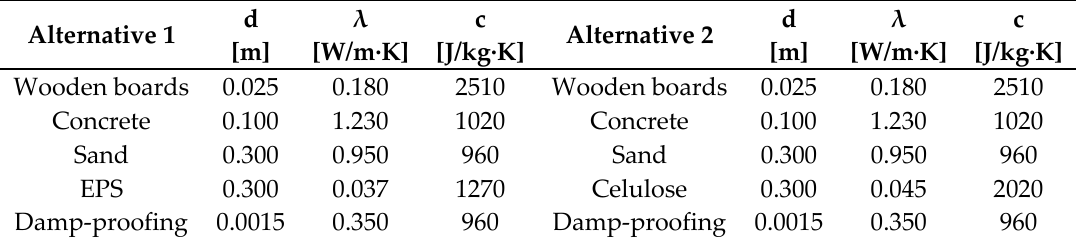
Table 3. Floors, Alternative 1—R = 8.65 m 2 ·K/W, U = 0.11 W/m 2 ·K, Alternative 2—R = 8.5 m 2 ·K/W, U = 0.11 W/m 2